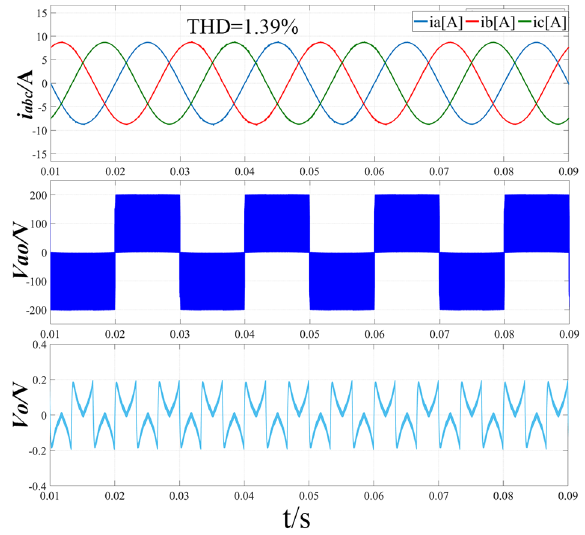
Figure 12. Simulation results of three-phase input current, line-to-neutral voltage and midpoint po- tential difference with improved hybrid modulation strategy (m = 0.51, Vdc = 400 V).